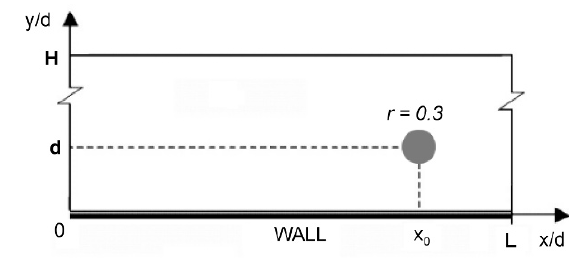
Figure 3. Computationaldomainoftheconsideredproblemwithvor- tex patch in its initial